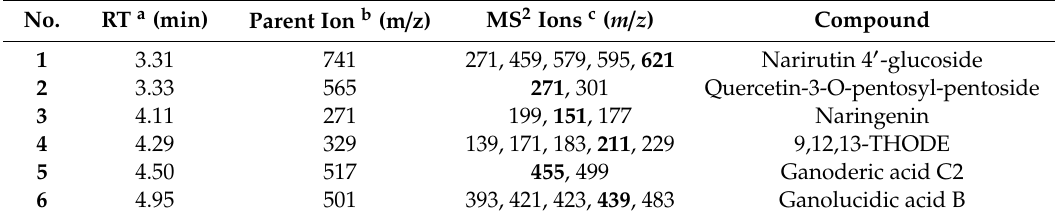
Figure 1. Q-TOF UPLC/MS chromatographic spectra in negative ion mode.